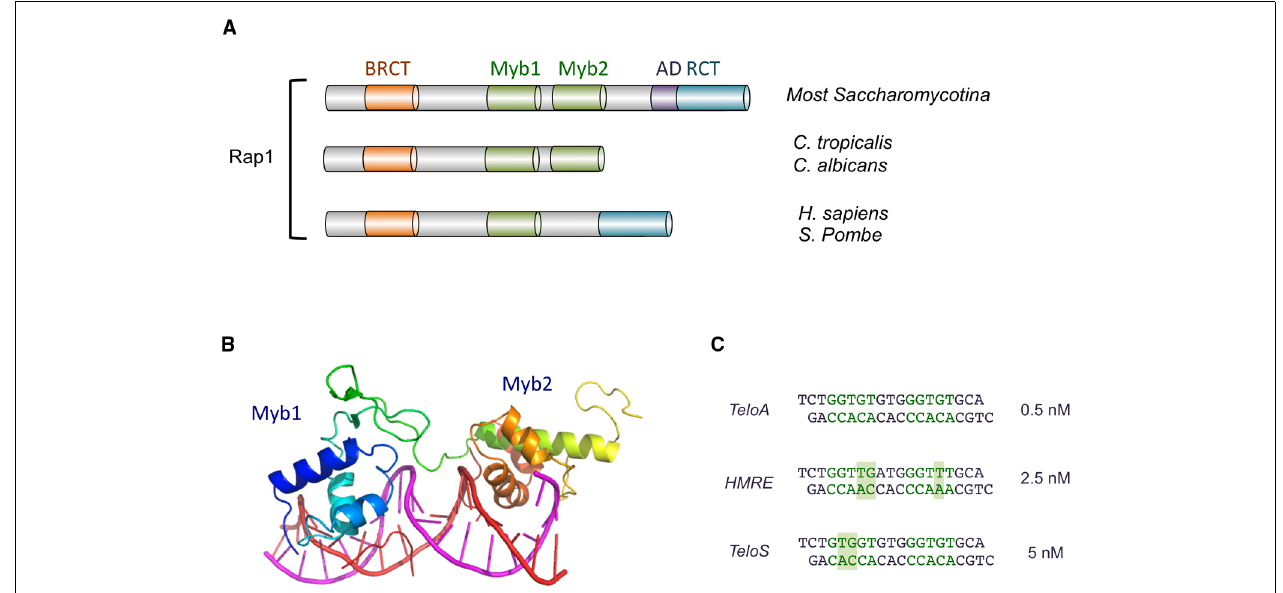
FIGURE 2 | The domain organization of Rap1 and the structure of Rap1 DBD -DNA complex. (A) The domain structures of Rap1 from various Saccharomycotina and other species are illustrated. The BRCT, Myb, AD (activation domain), and RCT (Rap1 C-terminal) domains are displayed in different colors. (B) The crystal structure of the Myb1 and Myb2 domains of S. cerevisiae Rap1 (shown in color spectrum from blue to orange) bound to its target DNA (shown in magenta and red; PDB ID: 1IGN). (C) The sequences of